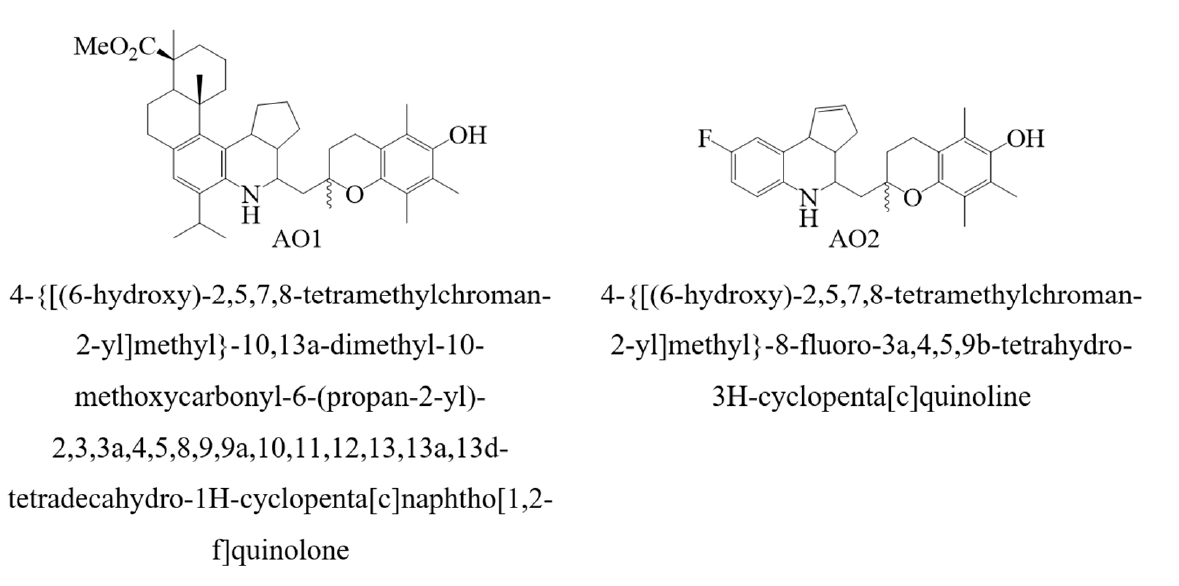
Figure 3. Structures of the compounds designated by AO1 and AO2.